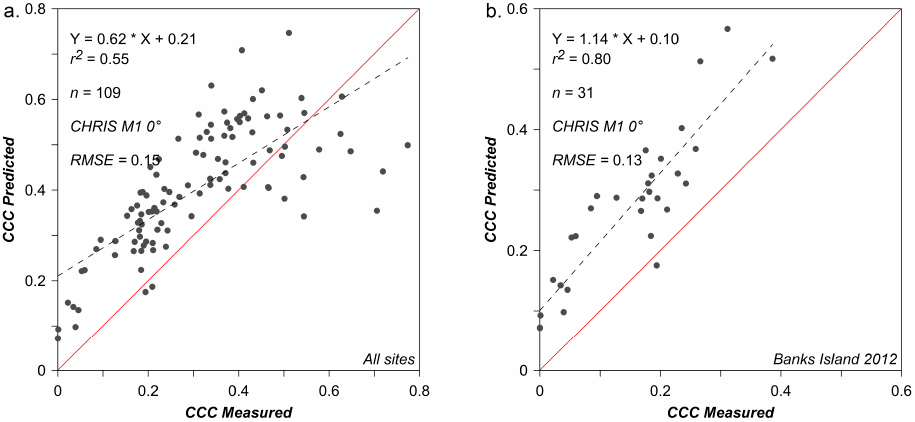
Figure 10. The best look-up table (LUT) inversion results for canopy chlorophyll content (CCC) for all sites ( a ) and Banks Island ( b ) using only CHRIS Mode-1 (M1) nadir (view zenith angle, VZA = 0°) acquisitions. Root mean square error (RMSE) units: CCC (g/m 2 ). The 1:1 identify line (red) is shown in each scatterplot to provide a comparative reference.